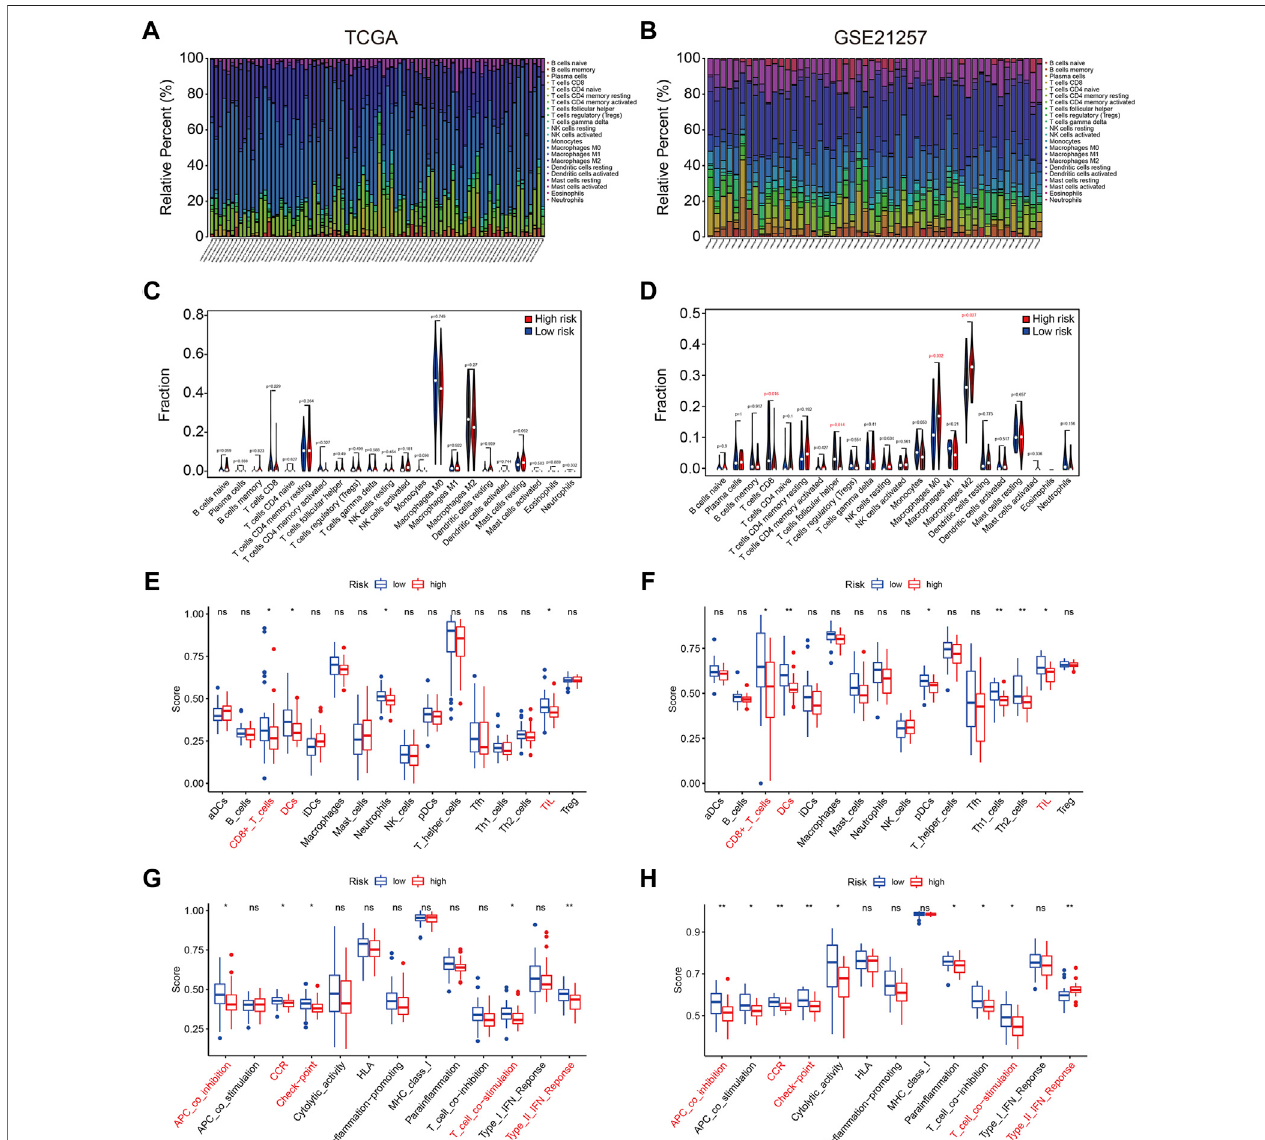
FIGURE9| Thefour SLC genesignaturewascorrelated withtumor immune cellin fi ltration. (A,B) Stacked bar chartexhibitedthe distribution of22immunecells in each osteosarcoma sample of the TCGA cohort and GSE21257 cohort. (C,D) Violin plots of immune cell in fi ltrates in high- and low-risk groups in TCGA cohort and GSE21257cohort. (E,F) Boxplotsshowedthescoresofvariousimmunesubpopulationsinhigh-andlow-riskgroupsinTCGAcohortandGSE21257cohort. (G,H) Box plots showed the scores of related-immune functions in high- and low-risk groups in TCGA cohort and GSE21257 cohort.